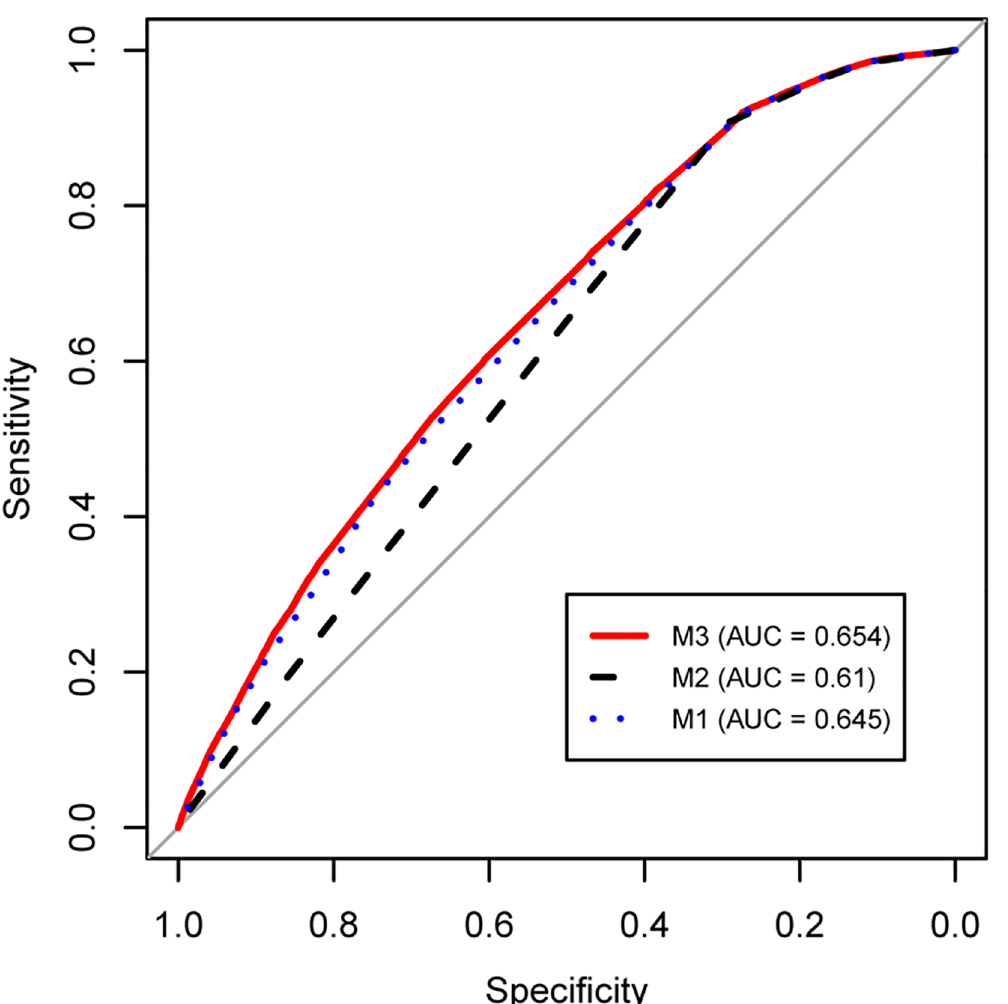
Fig 6. ROC curves for multivariate logistic models predicting SNP membership in GWAS. Components of the three predictive models are described in Fig